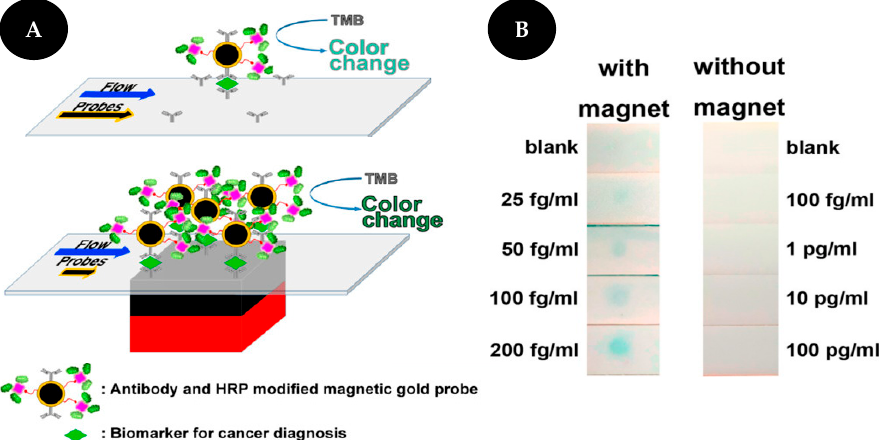
Figure 6. Scheme of VCP detection ( A ) without ( upper ) and with ( bottom ) magnet. Comparison of detection results of VCP ( B ) with ( left ) and without ( right ) magnet. Reproduced and adapted with permission from